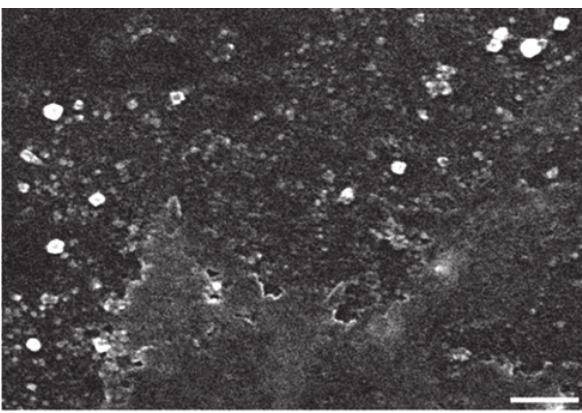
Figure 2: Scanning electron micrograph of aggregated and protein- capped silver NPs with a size range of 20 to 60 nm. Scale bar denotes 200 nm. Reprinted from Laborda et al.